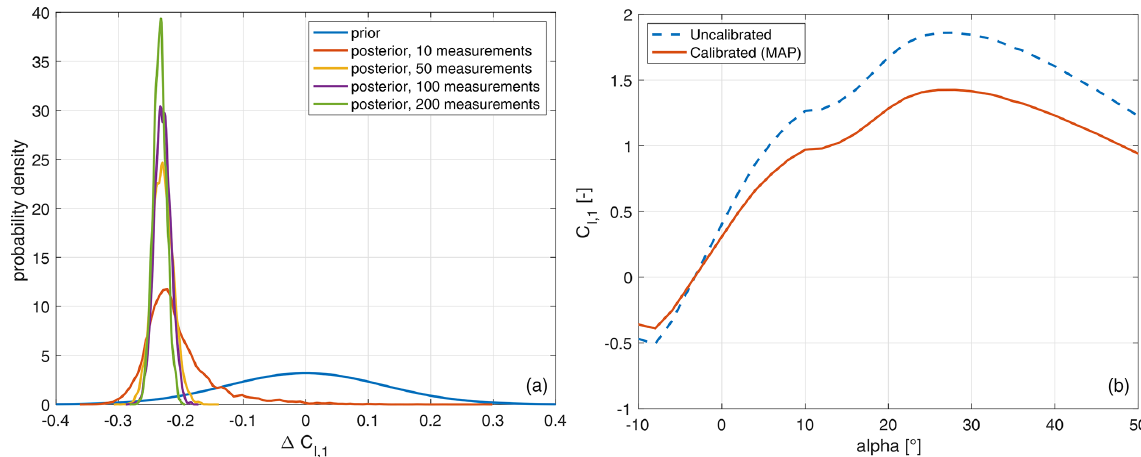
Figure 7. Calibration results for the lift coefficient at the first radial section. (a) Posterior of (cid:49)C l , 1 with increasing number of measurements. (b) The calibrated C l , 1 polar evaluated at the MAP of the posterior (obtained with 200 measurements), compared to the uncalibrated polar.